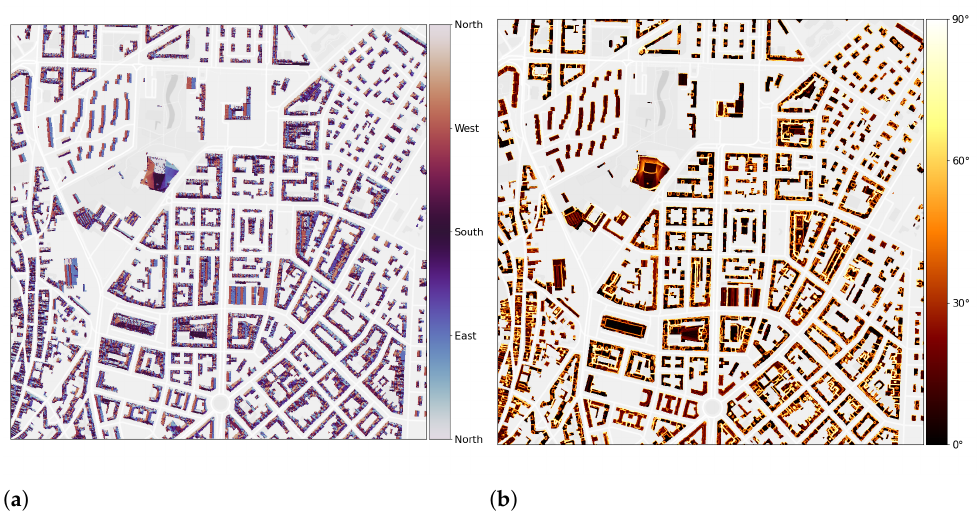
Figure 6. ( a ) Maps of aspect and ( b ) slope values computed for the building rooftops within the Municipality of Cagliari.